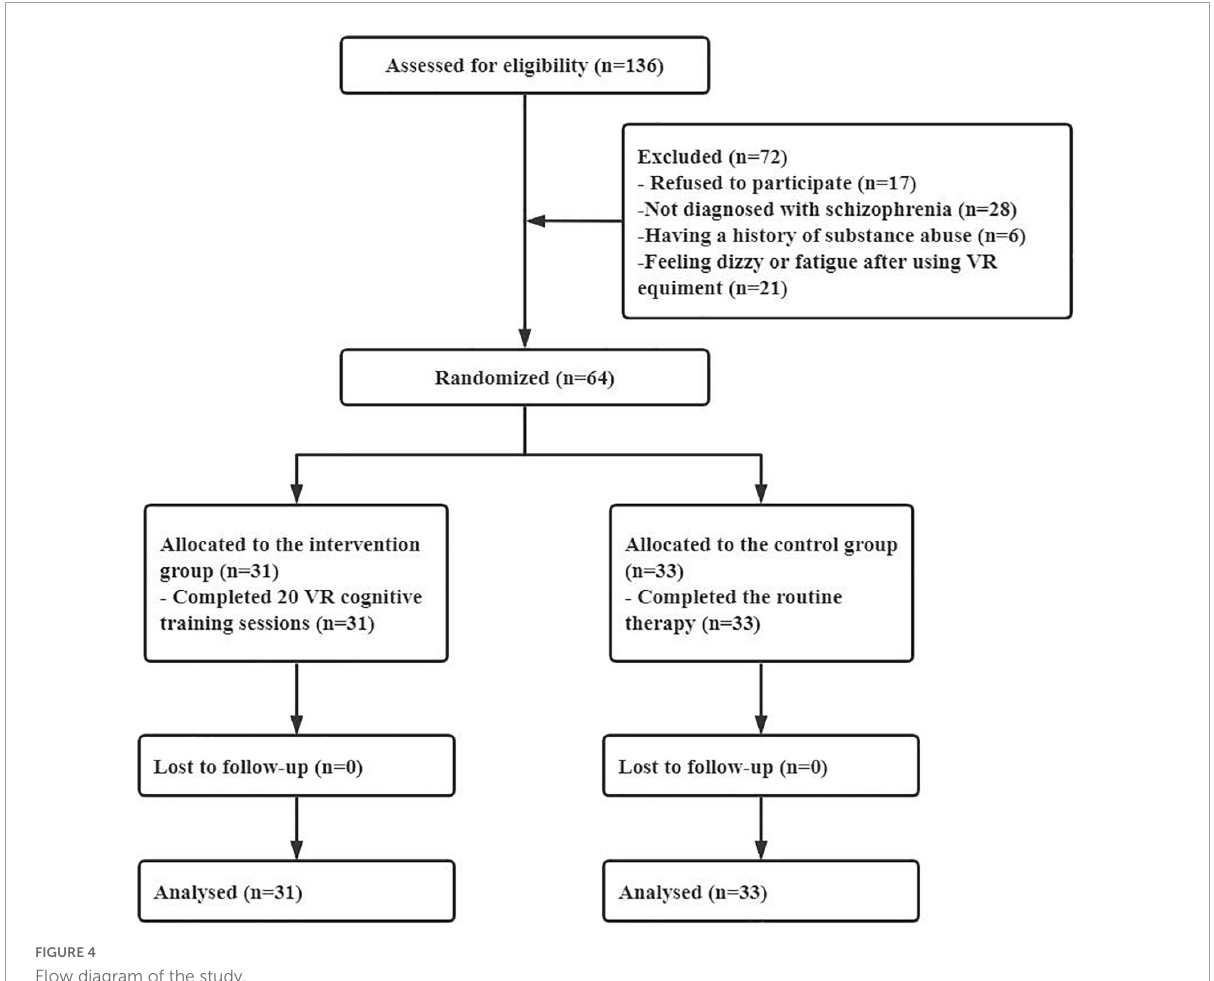
FIGURE4 Flow diagram of the study.